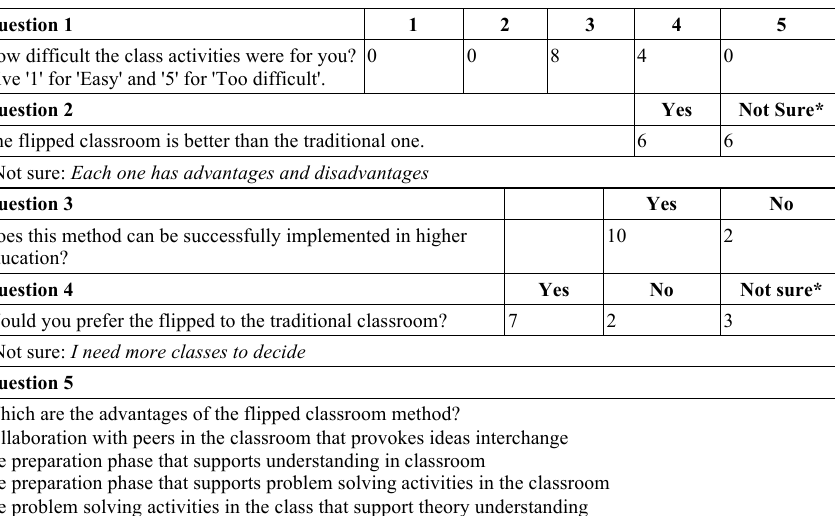
Table 2. Students’ answers on the in-class